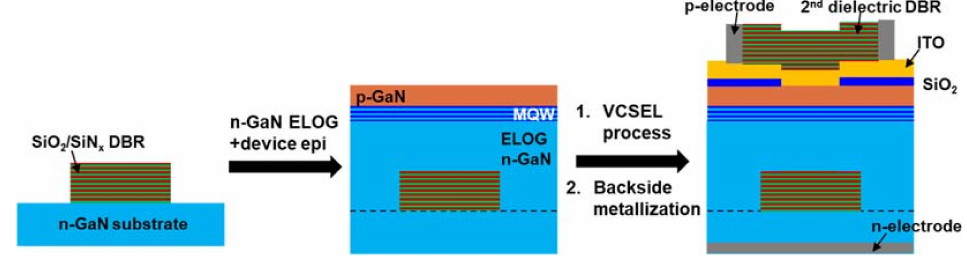
Figure 8. Schematic process route of dual-type VCSEL with ELOG bottom mirror.